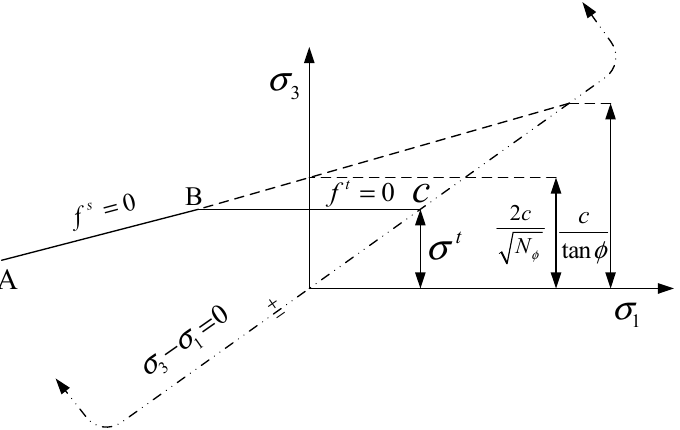
Figure 2. Mohr–Coulomb failure guidelines.